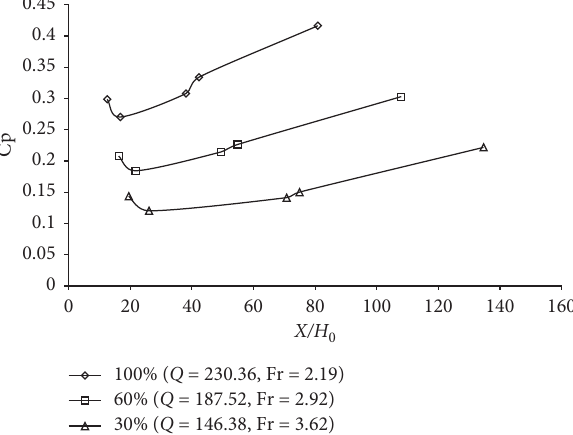
Figure 17: Piezometric pressure head distribution of triple waves for the performance of six middle gates’ operation.